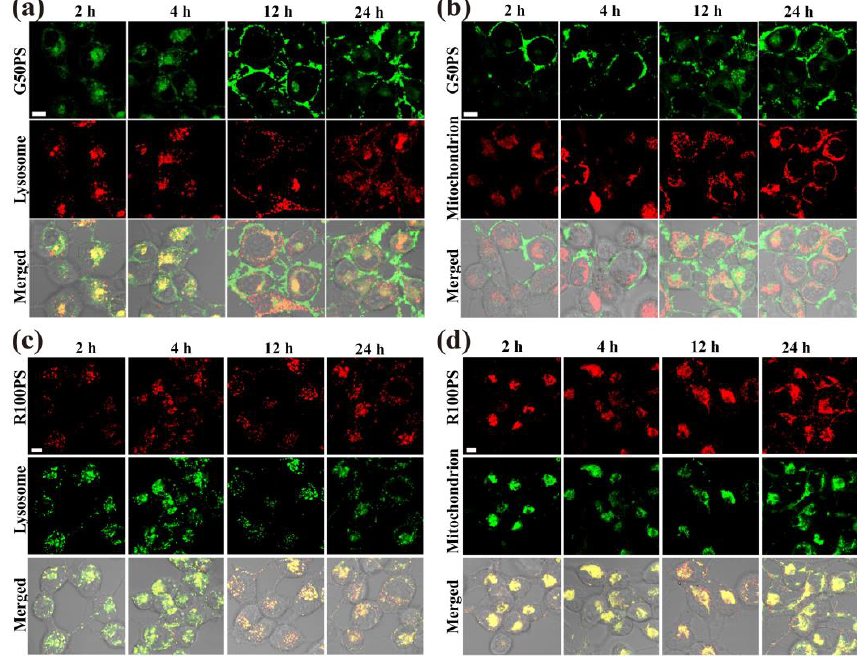
Figure 6. CLSM images of the subcellular location of PS NPs (20 μg/mL) in BEAS -2B cells after exposure to G50PS (green color) or R100PS (red color) for different times. Lysosomes and mitochondria are labeled red ( a-b ) or green ( c-d ). The scales represent 10 μm.